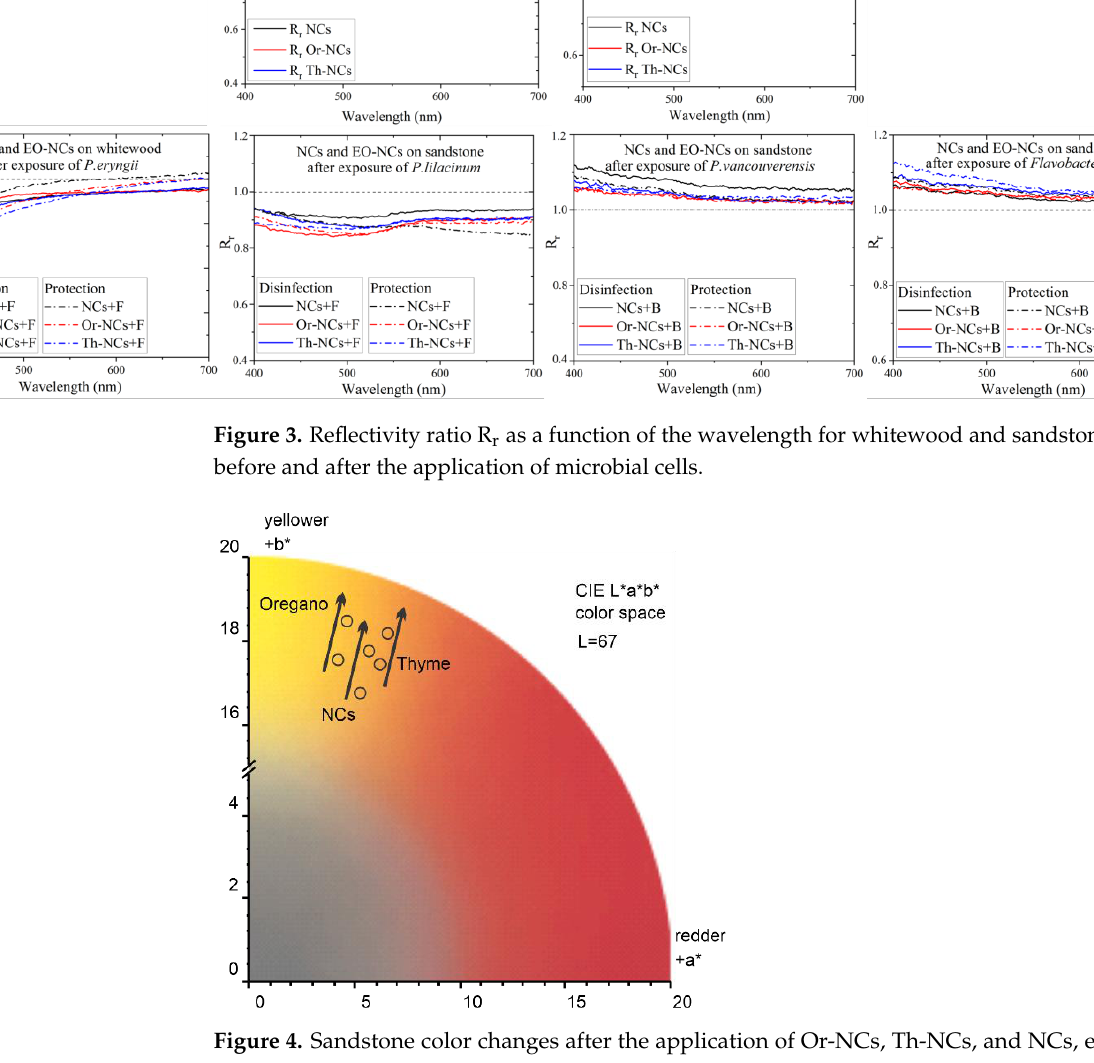
Figure 3. Reflectivity ratio R r as a function of the wavelength for whitewood and sandstone samples before and after the application of microbial cells.